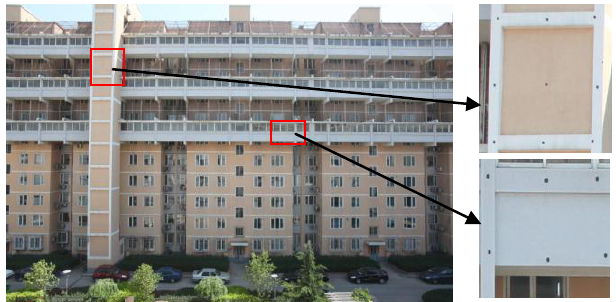
Figure 4. The outdoor calibration